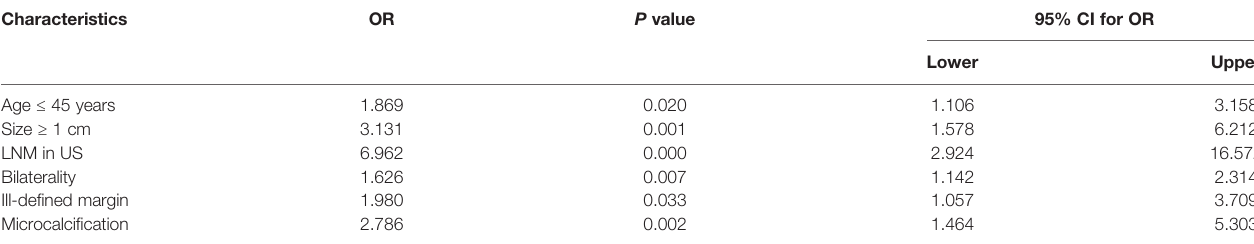
TABLE 4 | Multivariate logistic regression analyses: association between LNM and clinical/ultrasonic characteristics of PTCs with the BRAF V600E mutation. Characteristics